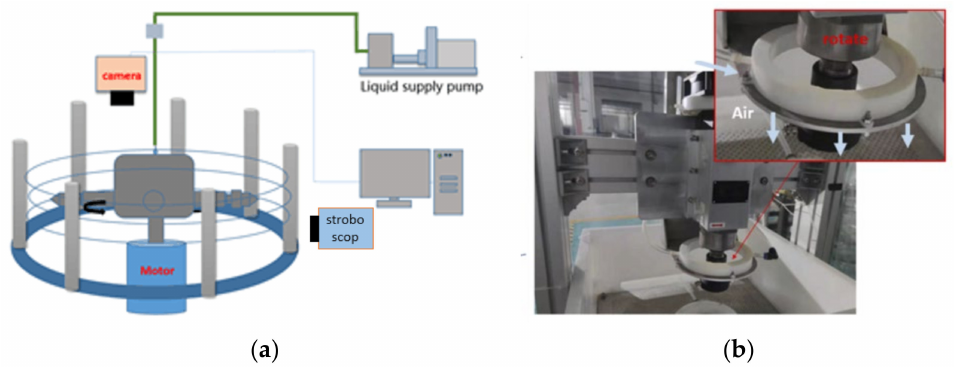
Figure 11. ( a ) Schematic diagram of centrifugal jet stroboscopic observation platform; ( b ) The image of centrifugal air-assisted